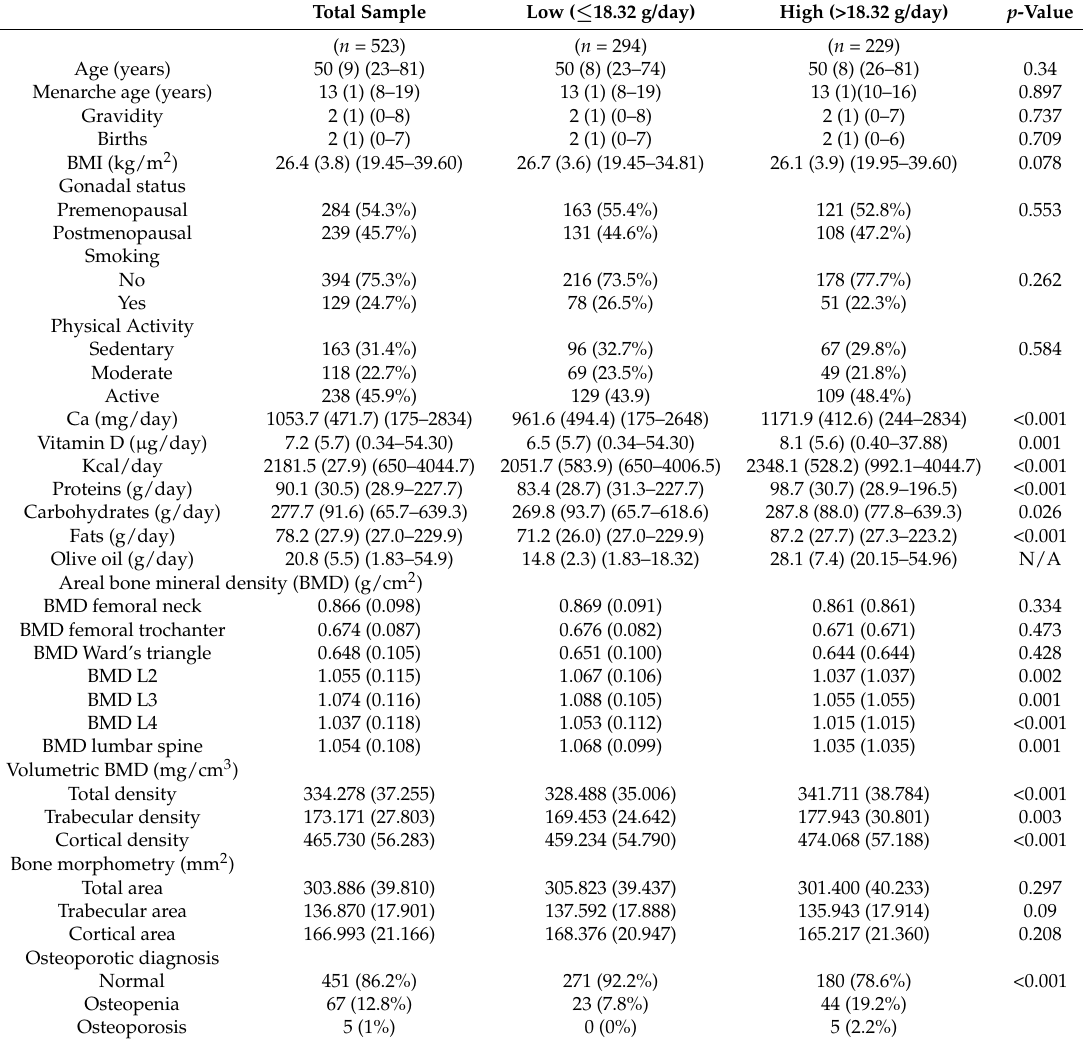
Table 1. Biological, anthropometric, dietetic, and densitometric factors in the studied sample by olive oil intake.